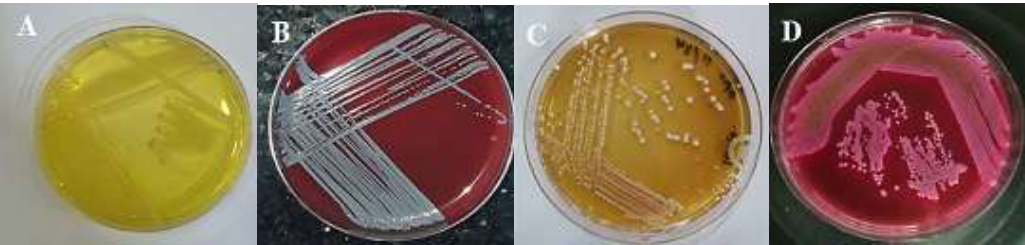
Figure 1: Shows bacterial isolates growing on culture media. (A), (B) S.haemolyticus on Mannitol salt agar, Blood agar, (C) L.gasseri on MRS agar, and (D) K.pneumoniae on MacConkey agar.